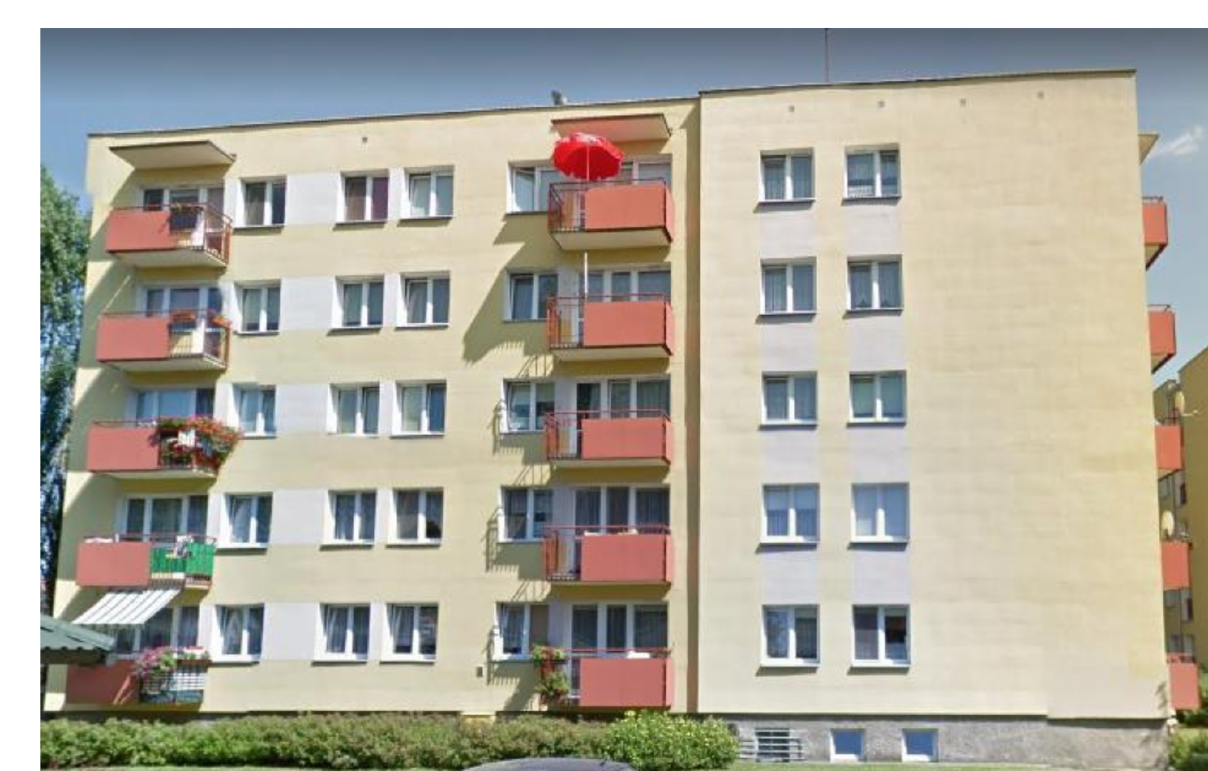
Figure 6. View of the analysed multi-family building.